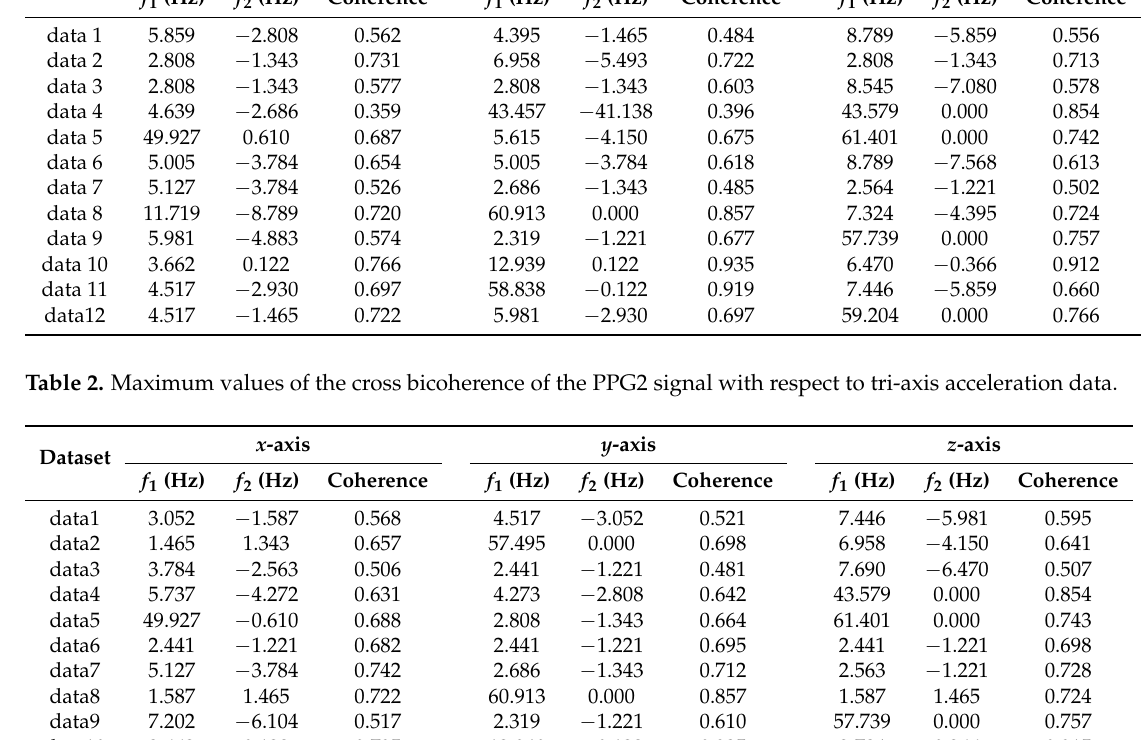
Table 1. Maximum values of the cross bicoherence of the PPG1 signal with respect to tri-axis acceleration data. Dataset